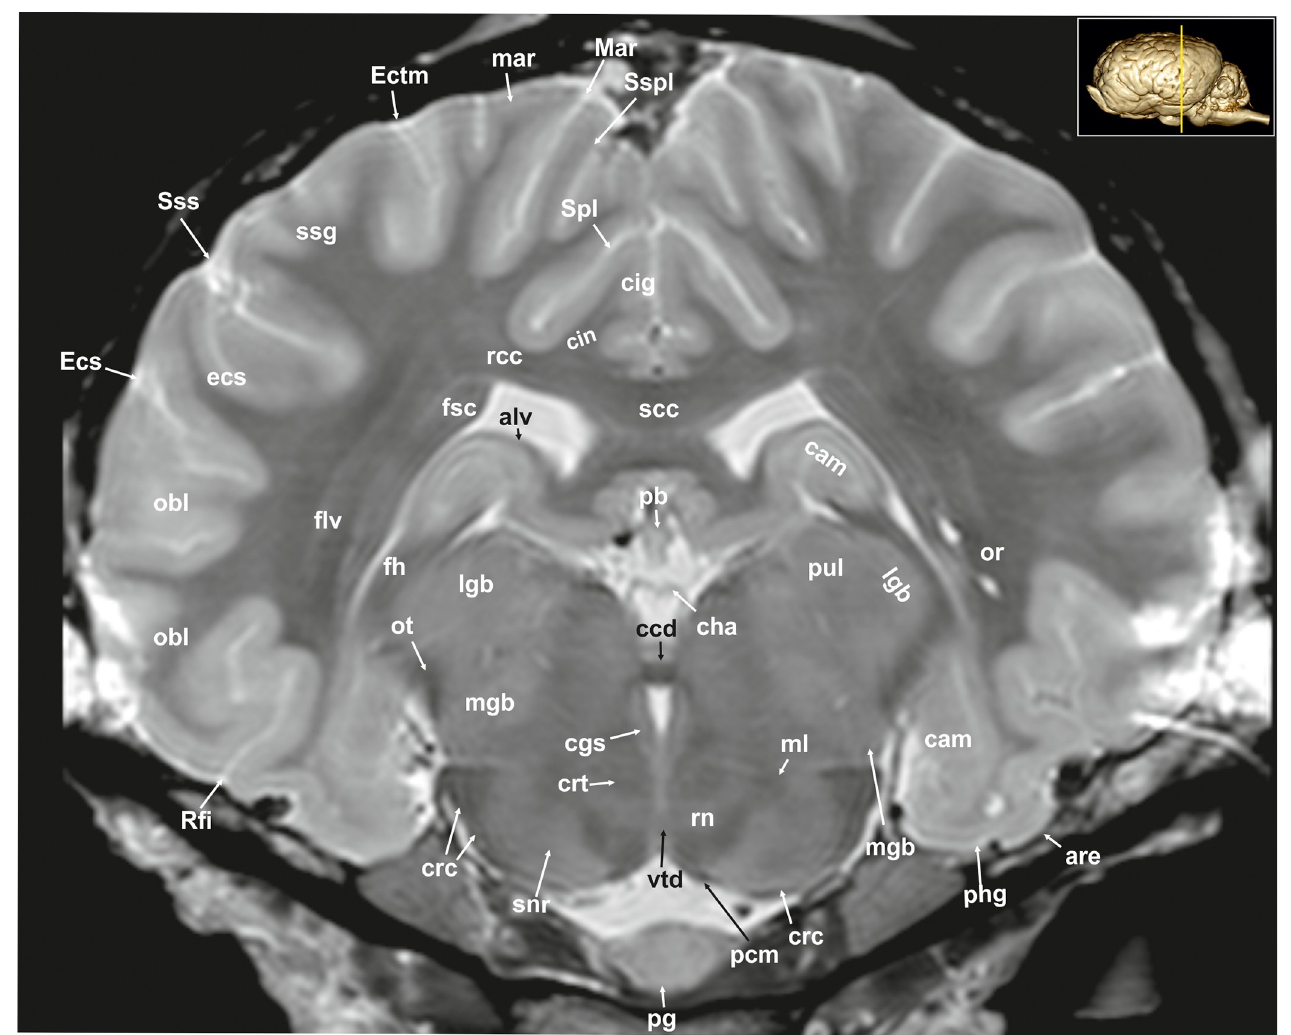
Fig 9. Transverse magnetic resonance image of the equine brain on the level of the caudal commissure. are: entorhinal area, alv: alveus; cam: ammon’s horn, ccd: caudal commissure, cdc: caudal colliculus, cgs: central grey substance, cha: habenular commissure, cig: cingulate gyrus, cin: cingulum, crc: cerebral crus, crt: rubro- cerebello-thalamic tract, df: dentate fascia, ecs: ectosylvian gyrus, Ecs: ectosylvian sulcus, Ectm: ectomarginal suclcus, flv: ventral longitudinal fasciculus, fsc: subcallosal fasciculus, lgb: lateral geniculate body, mar: marginal gyrus, Mar: marginal sulcus, mgb: medial geniculate body, ml: medial lemniscus, obl: oblique gyrus, or: optic radiation, ot: optic tract, pb: pineal body, pcm: peduncles of the mammillary body, pg: pituitary gland, phg: parahippocampal gyrus, pul: pulvinar nuclei, rcc: radiation of corpus callosum, Rfi: rhinal fissure, rn: red nucleus, scc: splenium of corpus callosum, snr: substantia nigra, Spl: splenial sulcus, ssg: suprasylvian gyrus, Sspl: suprasplenial sulcus, Sss: suprasylvian sulcus, vtd: ventral tegmental decussation.